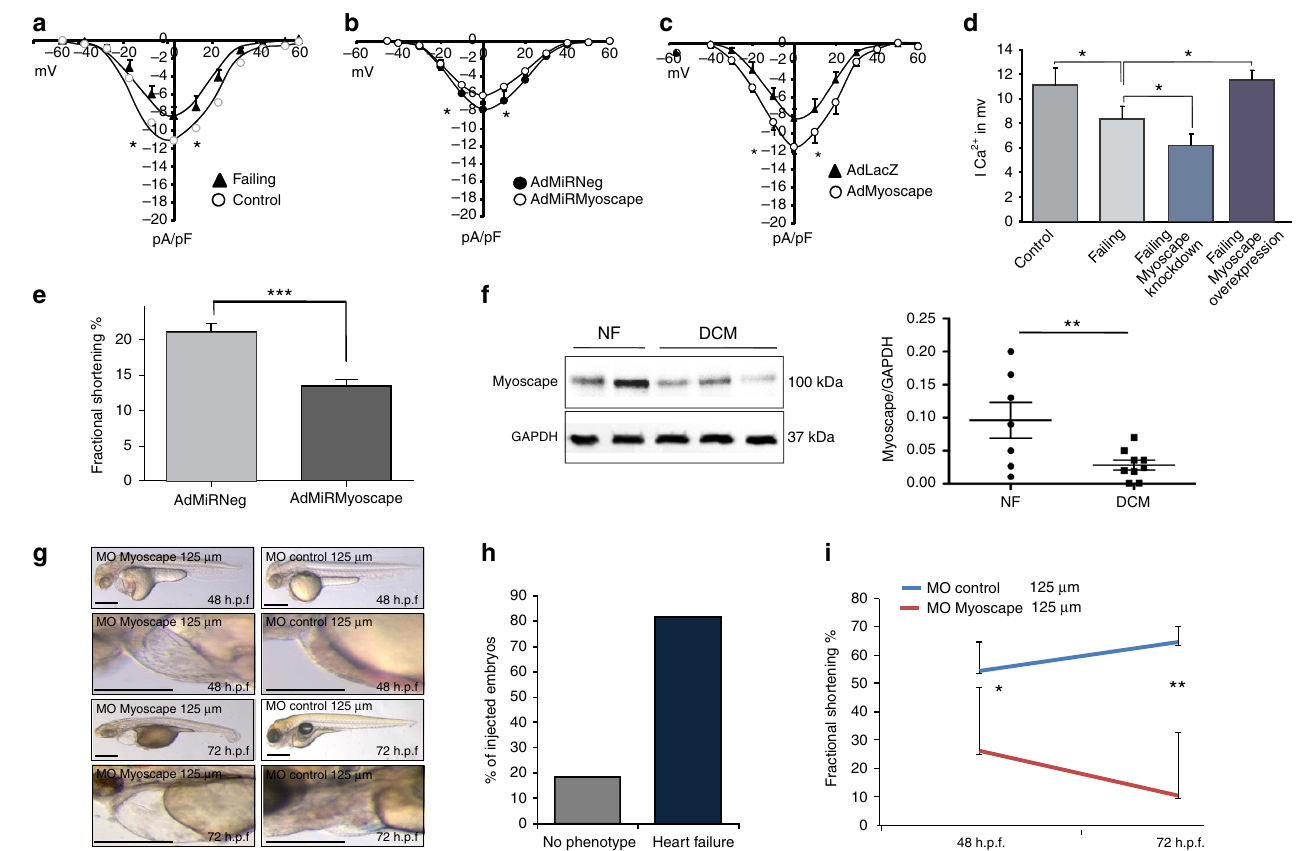
Figure 3 | Myoscape ablation and heart failure. ( a ) Measurements of whole-cell L-type calcium currents in failing rat ARVCMs isolated from rat hearts after cryoinfarction, compared with non-failing (sham operated) controls at baseline or ( b ) after adenoviral Myoscape knockdown or ( c ) Myoscape overexpression, respectively ( n ¼ 7–9, * P o 0.05 (ANOVA)). ( d ) Summary of the L-type calcium currents under different experimental conditions, showing either restoration of calcium currents or a further reduction depending on Myoscape protein content. ( n ¼ 7, * P o 0.05 (ANOVA)) ( e ). To elucidate the functional consequences of myoscape downregulation on cardiomyocyte contractile function, again adult ventricular rat cardiomyocytes were utilized. On the first day of culture, ARVCMs where infected with AdMiRMyocape or control virus (AdMiRNeg). Fractional shortening was assessed by video edge detection evaluated by an observer blinded to experimental conditions. ARVCMs infected with AdMiRMyoscape showed a significant reduction in fractional shortening compared with ARVCM’s infected with control virus (21 ± 1% versus 14 ± 1%, in 60 assessed cells, and n ¼ 3 independent cell preparations, *** P o 0.001 (ANOVA)). ( f ) Downregulation of Myoscape protein content was shown via western blot analyses in biopsies from patients suffering from end-stage heart failure due to dilated cardiomyopathy (DCM) and compared with control heart samples from individuals who died from a non-cardiovascular-cause ( n ¼ 7–8). GAPDH served as a loading control (left panel). A statistical evaluation was done of all samples showing a significant decrease of Myoscape/GAPDH ratios. ** P o 0.01 (ANOVA). ( g ) Morpholino knockdown of zebrafish Myoscape results in severe contractile dysfunction. Myoscape knockdown morphants (lateral view) develop pericardial oedema and blood congestion due to low cardiac performance. By contrast, cardiac function of MO-control injected zebrafish embryos was unaffected after 48 or 72h.p.f. ( h ) Quantitative evaluation showing 81.7% of Myoscape knockdown morphant zebrafish developing cardiac failure after injection. The presence of heart failure was assessed by evaluation of reduced ventricular function and development of pericardial oedema and precardial signs of blood congestion. Functional assessment of cardiac contractility was carried out by a Zeiss MCU II microscope with the help of the zebraFS software. ( i ) Fractional shortening (FS) of the ventricular chamber of wild-type and Myoscape-deficient embryos measured at different developmental stages (48 and 72h.p.f.). * P o 0.05; ** P o 0.01 (ANOVA). Scale bars, 25 m m.